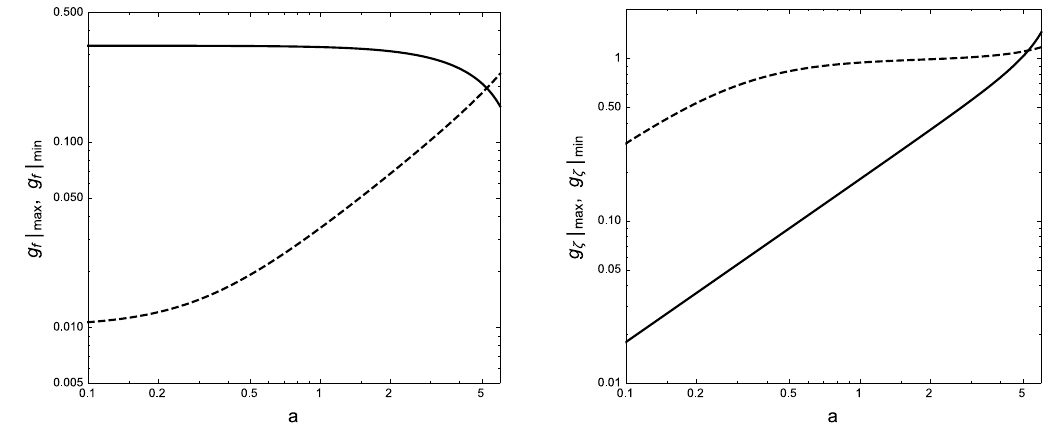
Figure 2 . Left panel : the maximum (solid line) and minimum (dashed line) values of g f as a function of a , corresponding to g BL | minimum (solid line) values of g ζ as a function of a , corresponding to g BL |